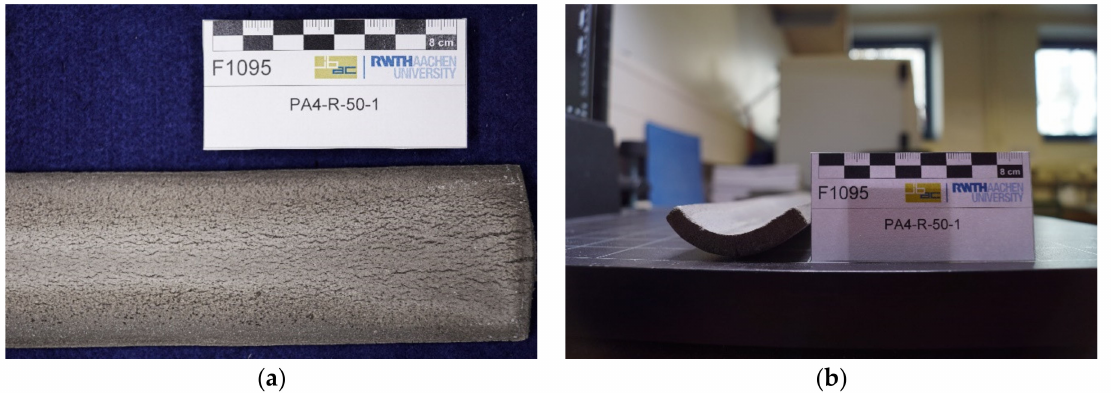
Figure 9. ( a ) Bottom of transversally formed mortar specimen of mixture 1 with visible cracks of approx. 0.4 mm, bending radius approx. 3.8 cm; ( b ) side view of transversally formed mortar specimen of mixture 1, radius approx. 3.8